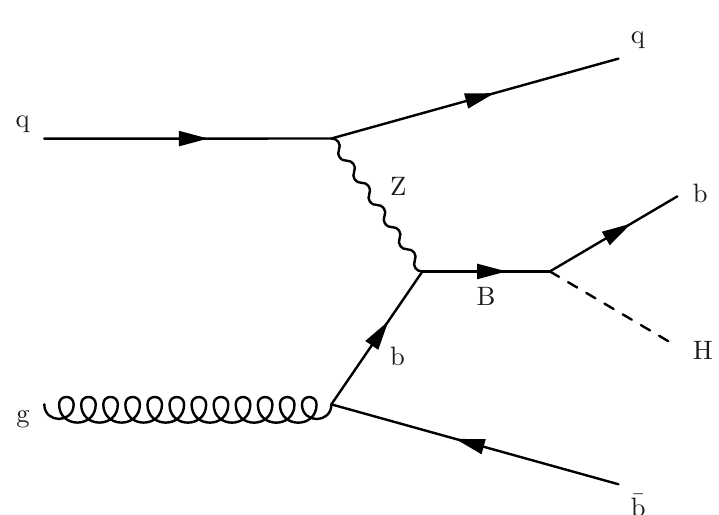
Figure 1. The leading-order Feynman diagram for the production of a single vector-like B quark in association with a b quark and light-(cid:13)avour quark, and its decay to a Higgs boson and a b